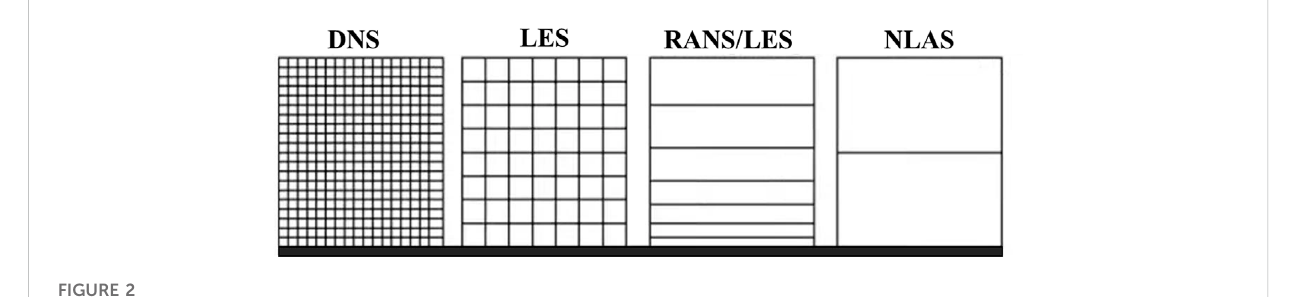
Common method near-wall mesh